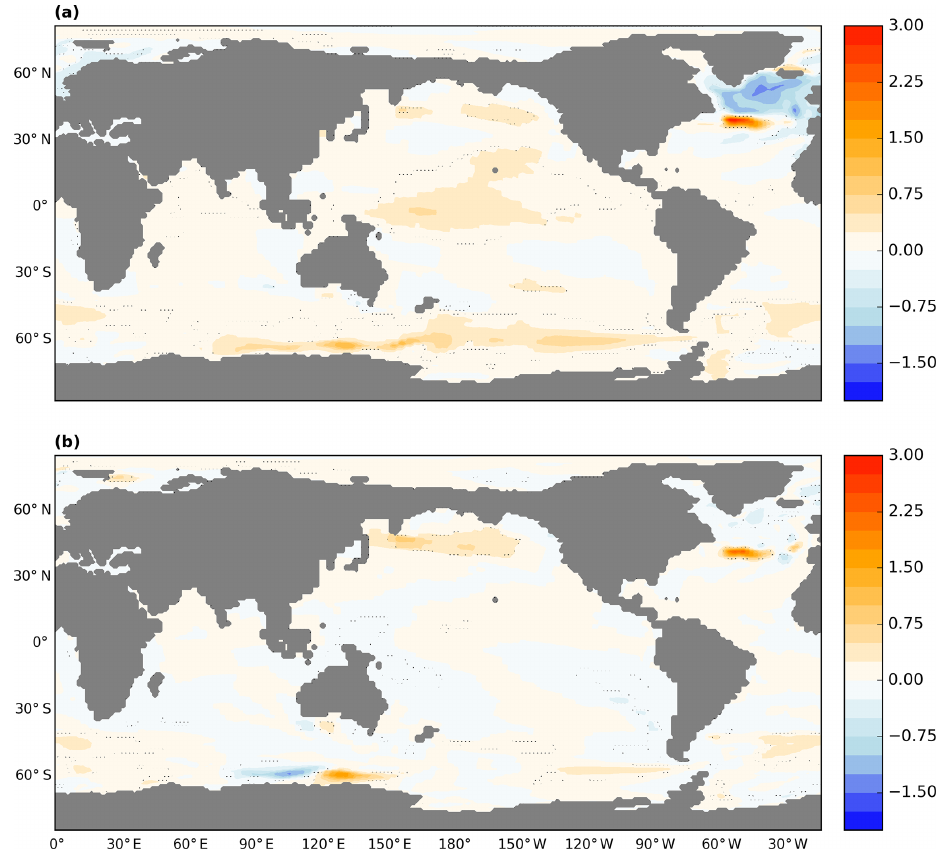
Figure 9. Annual mean SST ( ◦ C) anomalies between mid-Pliocene simulations with varying boundary conditions. (a) Eoi405 − Eoi400, quantifying anomalies due to changes in mid-Pliocene CO 2 from 405 to 400ppmv, as utilized for PlioMIP1 and PlioMIP2, respectively. (b) Eoi400_ORB − Eoi400, quantifying changes in the (PI and KM5c) orbital configuration as utilized in COSMOS simulations for PlioMIP1 and PlioMIP2.